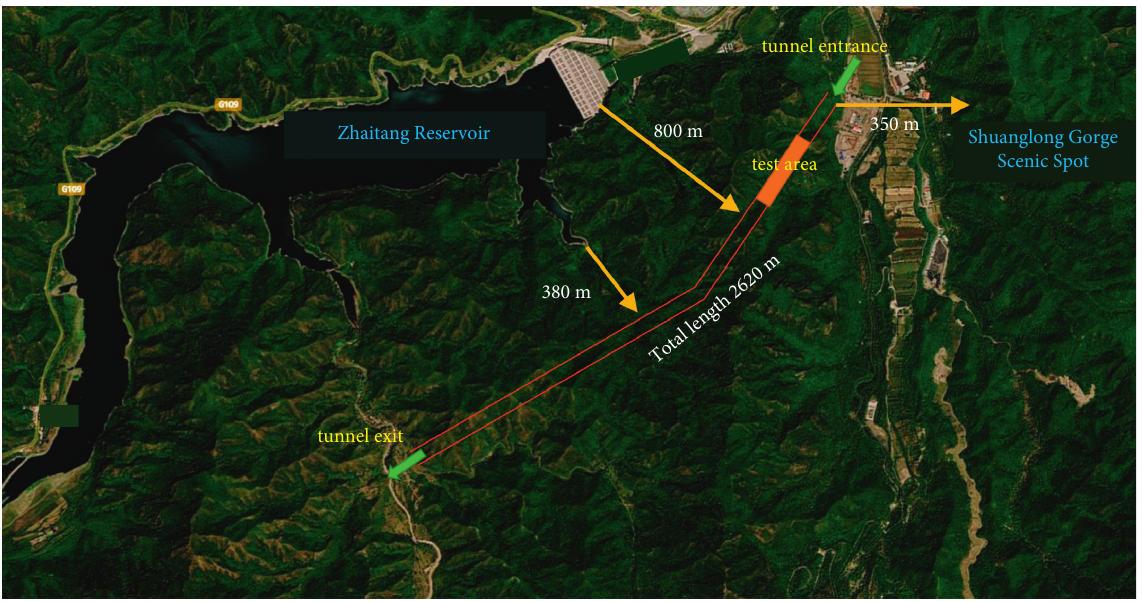
Figure 1: Schematic diagram of Zhaitang 1#